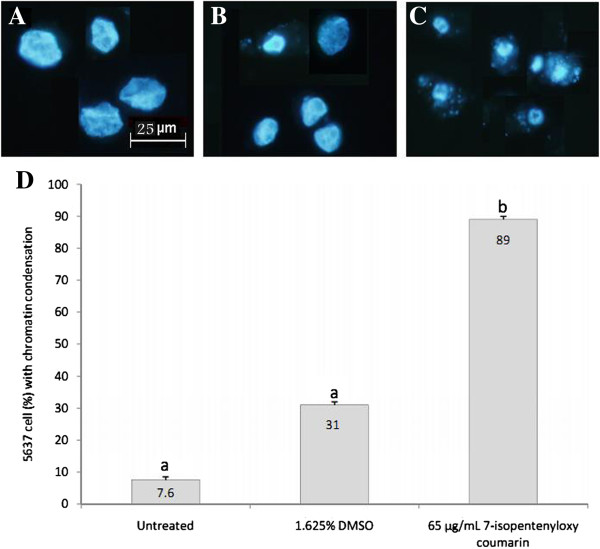
Investigating the apoptotic morphology of cells by DAPI staining. Chromatin condensation of 5637 cells without any treatment (A), treated with 1.625% DMSO (B) and treated with 65 μg/ml 7-IP (C) for 72 h. The percentages of condensed chromatin, 72 h after treatments are compared with untreated and control groups (D). Data are expressed as mean ± SD. The assay was done three times. Distinct letters indicate significant differences (P < 0.001) between cells treated with 65 μg/ml 7-IP and other cultures.